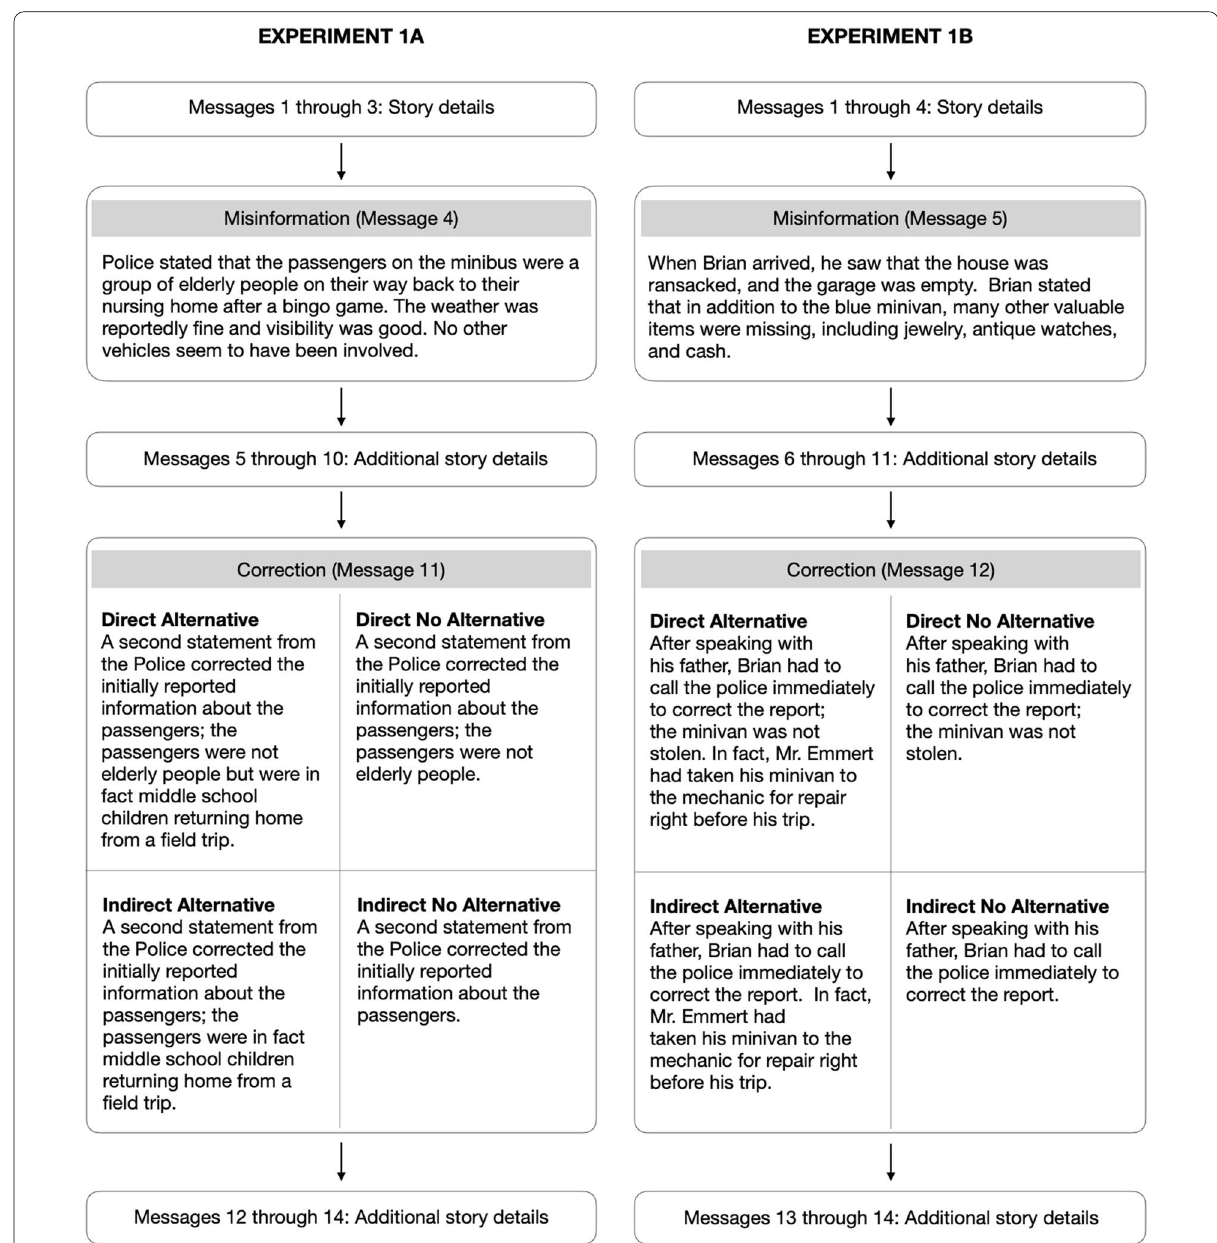
Fig. 1 Summary of message sequence and additional details for experimental conditions in Experiment 1A (left panel) and Experiment 1B (right